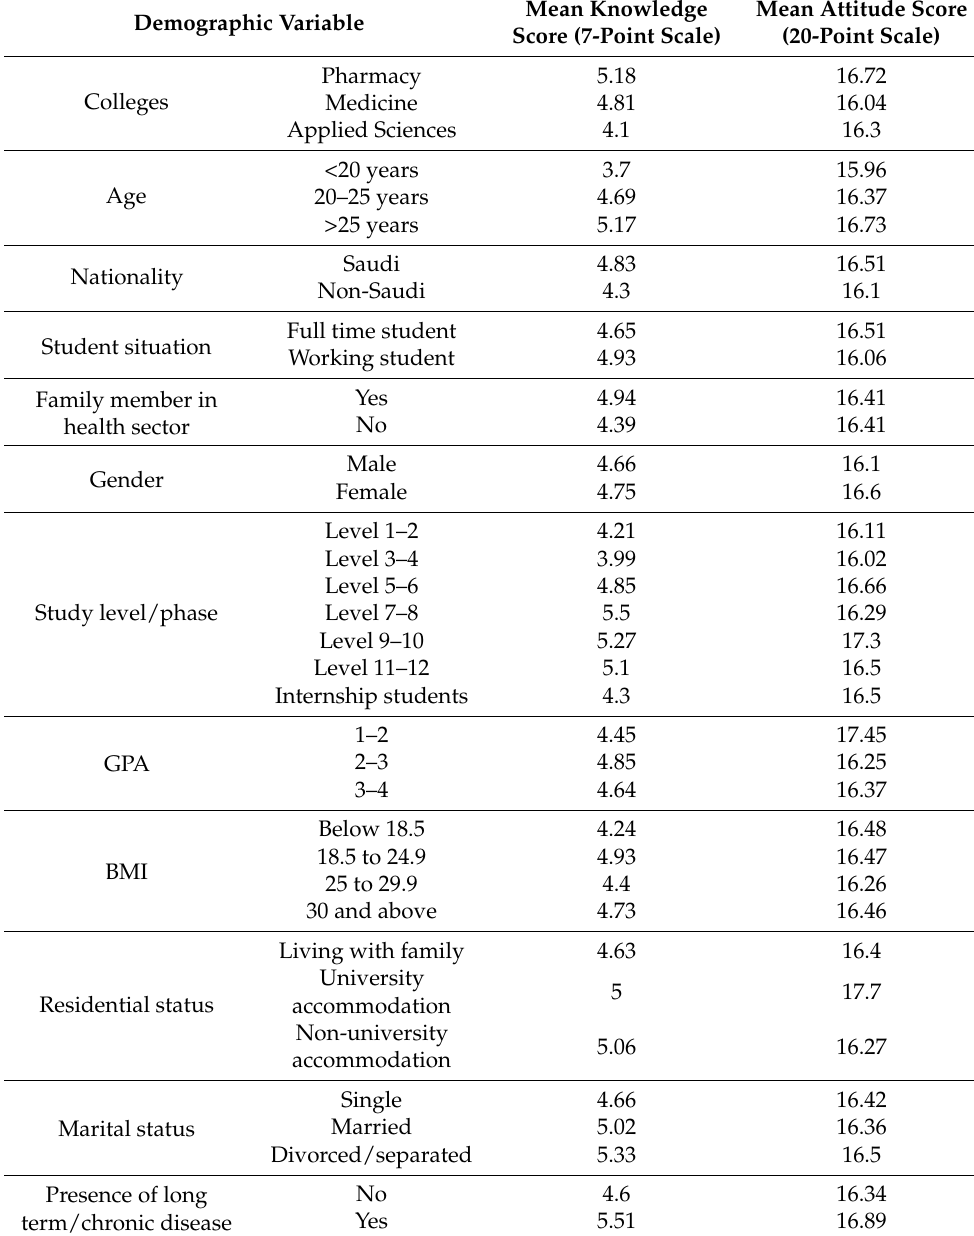
Table 2. Mean knowledge and attitude scores against demographic